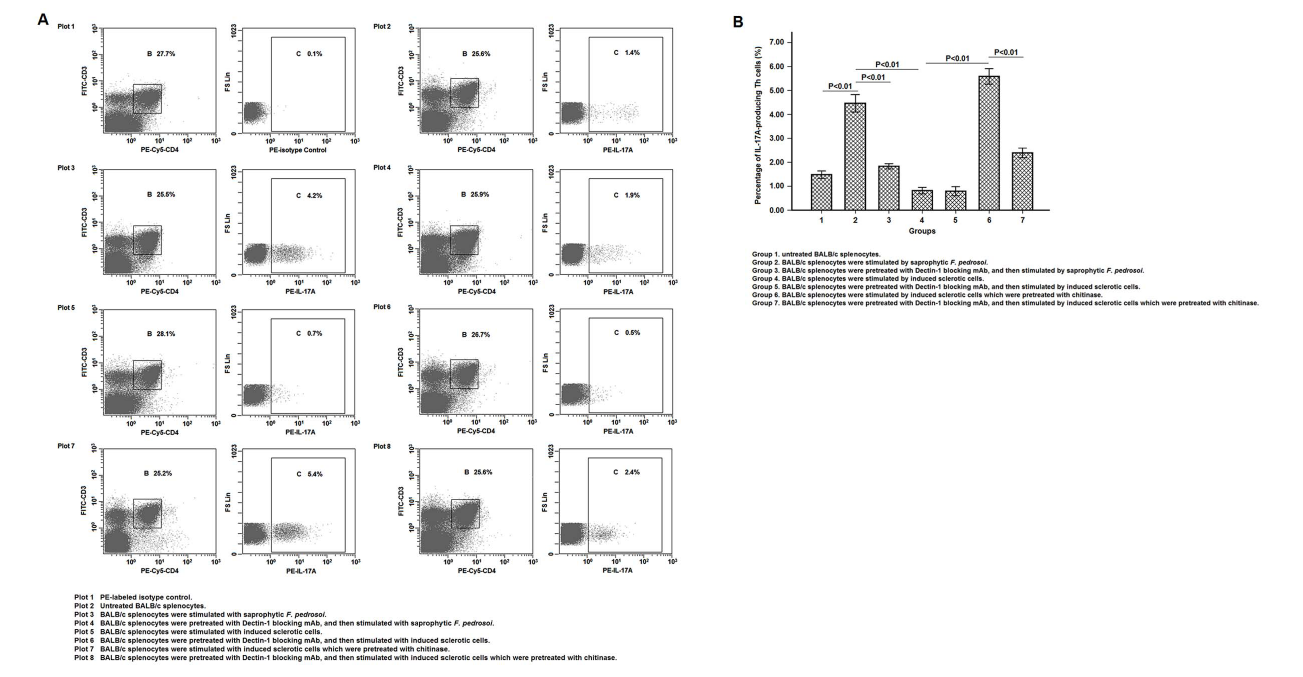
Fig. 6. Chitin moieties on the sclerotic cells of F. pedrosoi partly suppressed Dectin-1-mediated Th17 development. (A) The percentage of IL-17A- expressing Th cells in CD3 + CD4 + splenocytes was detected by FITC-anti-murine CD3, PE-Cy5-anti-murine CD4 and PE-anti-murine IL-17A using flow cytometry. The splenocytes stained with FITC-CD3 and PE-Cy5-CD4, and then with intracellular PE-Rat IgG2a were set as isotype controls. (B) Data are shown as mean ¡¡ SEM from four individual experiments performed in triplicates, and significance tested using LSD-t test.